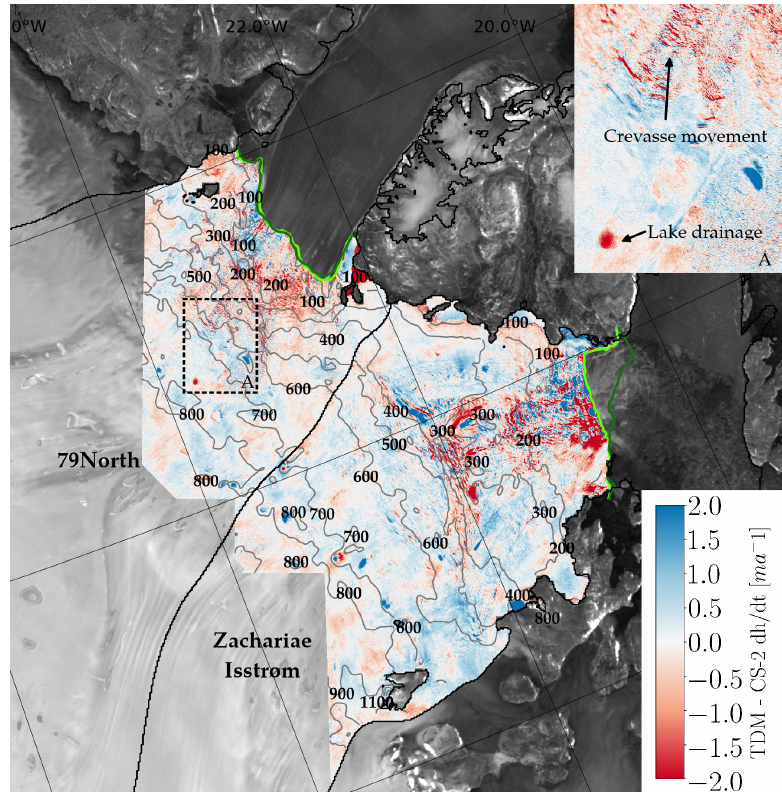
Figure 8. Differences of the TDM SECR map compared to the CS-2 surface elevation change trends from AWI swath processing (TDM—CS-2 AWI swath) for the terminus region of Zachariæ Isstrøm and 79North where SEC from both sensors is